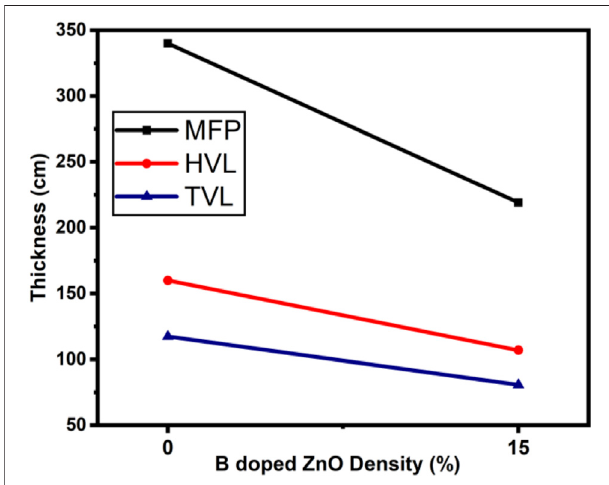
FIGURE 12 | Mean Free Path, Half-value Layer and One-tenth Value Layer of B doped ZnO (0 and 15%).